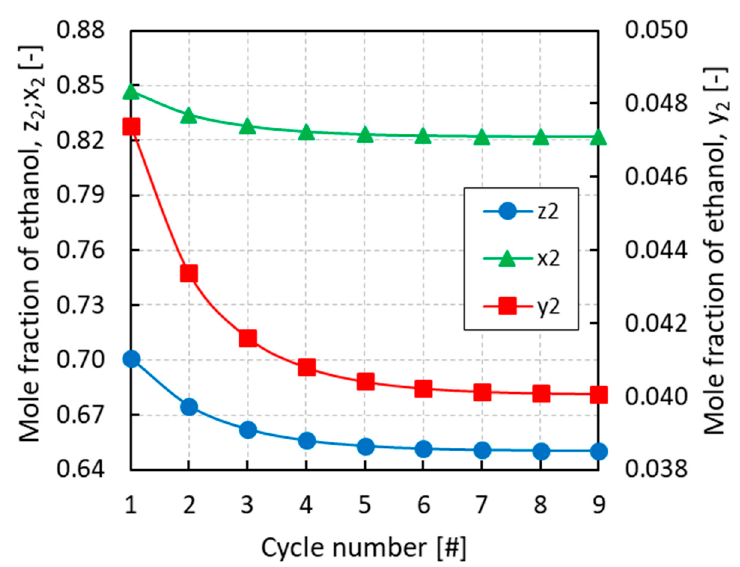
Figure 5. Evolution of the overall mole fraction ( z 2 ), the mole fraction in the vapor phase ( y 2 ), and the mole fraction in the liquid phase ( x 2 ) of ethanol in the condenser with the cycle number for an initial overall mole fraction of ethanol z 2 = 0.75.